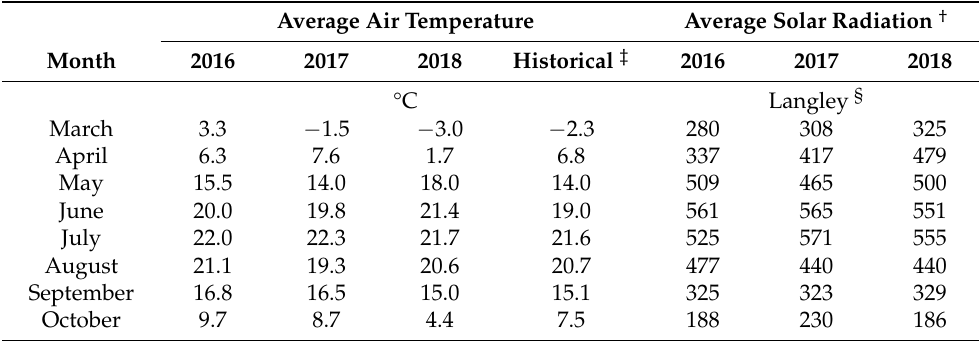
Table 5. Analysis of variance and mean squares for cover crops (CC) and cultivars (Cul) across four environments (Env) in